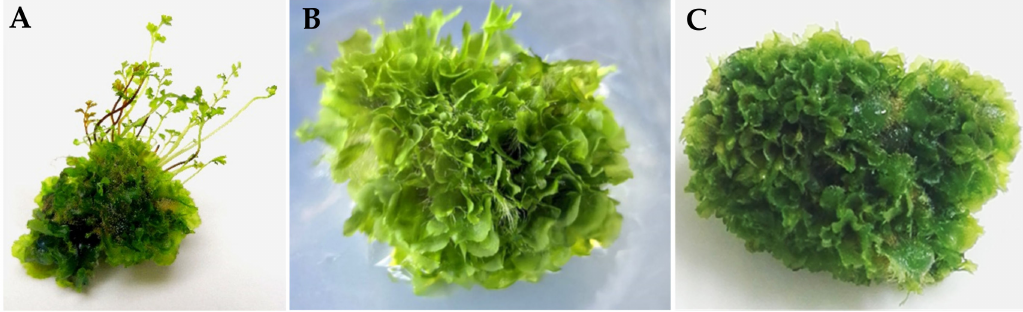
Figure 3. Morphological difference of three different genotypic H. serrata . ( A ) HB. ( B ) FJ. ( C )